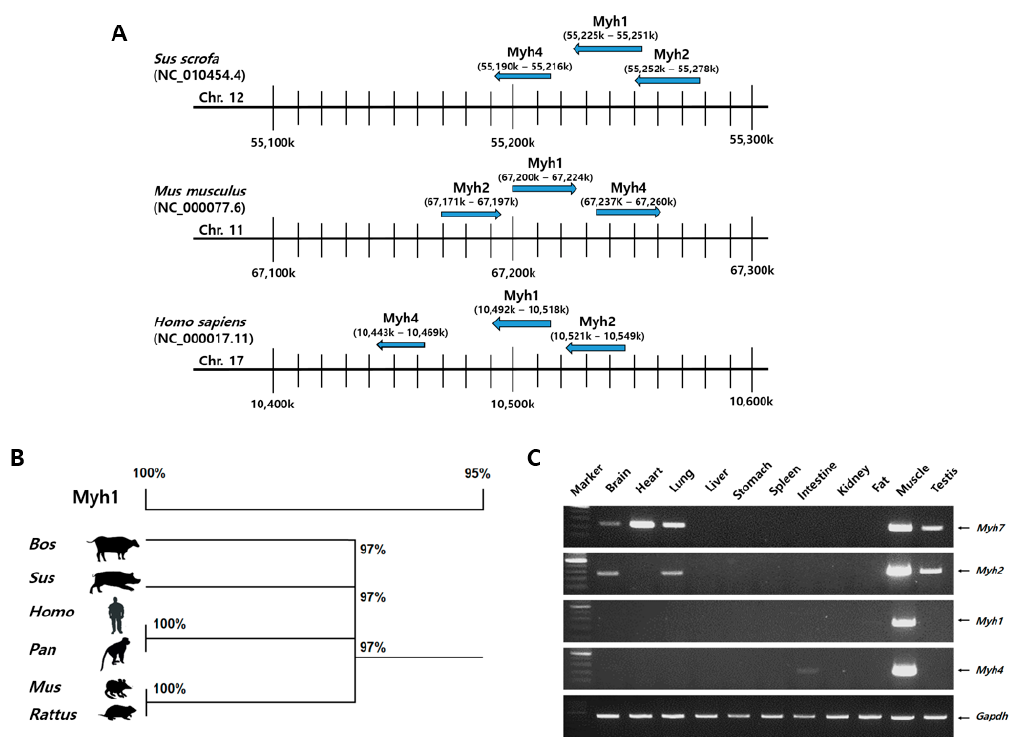
Figure 1. Identification of porcine Myh1 gene. Multiple protein sequence alignment of Myh1 gene in other species. ( A ) Myosin heavy chain gene clusters with species-specific loci. According to the NCBI annotations, Myh family genes that are associated with meat quality traits were located closely: Sus scrofa 11.1, Homo sapiens GRCh38.p12, and Mus musculus GRCm38.p6. ( B ) Homology and phylogenetic tree of Myh1 gene. The number represents the open reading frame (ORF) homology percentage and difference between the ORF sequence in vertebrate species through an alignment tree using the NCBI database and the DNAMAN program. Bos: Bos taurus (NM 174117.1); Sus: Sus scrofa (NM 001104951.1); Homo: Homo sapiens (NM 005963.3); Pan: Pan troglodytes (XM 003953128.2); Mus: Mus musculus (NM 030679.1); Rattus: Rattus norvegicus (NM 001135158.1). ( C ) Comparisons of expression patterns of MyHC isoforms in pig tissue. RT-PCR was performed to identify the expression patterns in diverse pig tissues. Porcine Gapdh was used as an internal control.